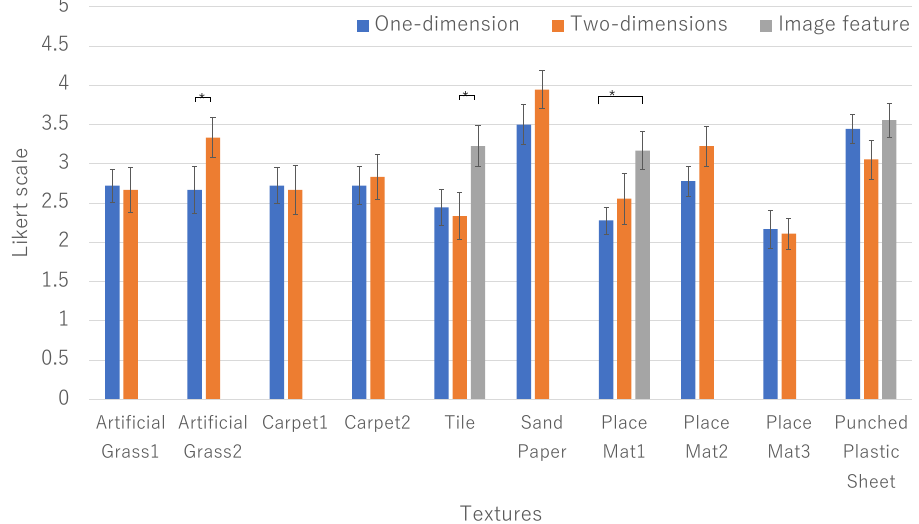
Figure 8. Reproducibility in 5 staged Likert